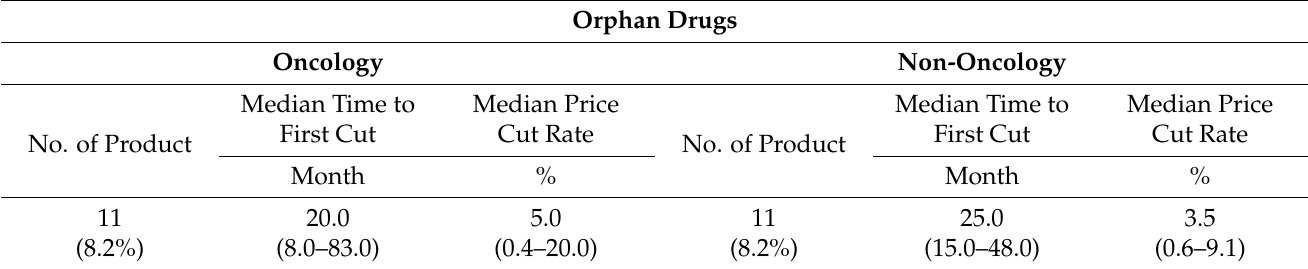
Table 7. Time elapsed until the first price cut after listing and its rate of new orphan